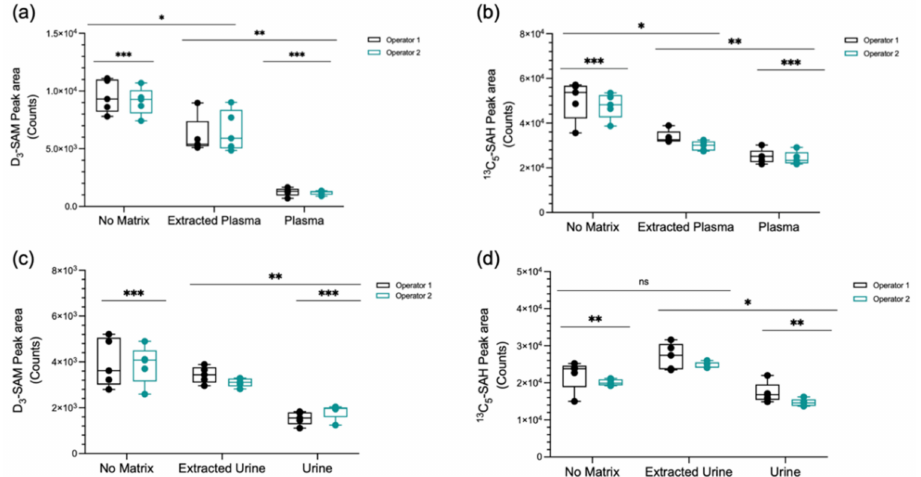
Figure 3. Analysis of the matrix effect by two independent users (operators 1 (black) and 2 (teal)). ( a ) Effect of extracted plasma and native plasma on the peak area of D 3 -SAM. ( b ) Effect of extracted plasma and native plasma on the peak area of 13 C 5 -SAH. ( c ) Effect of extracted urine and native urine on the peak area of D 3 -SAM. ( d ) Effect of extracted urine and native urine on the peak area of 13